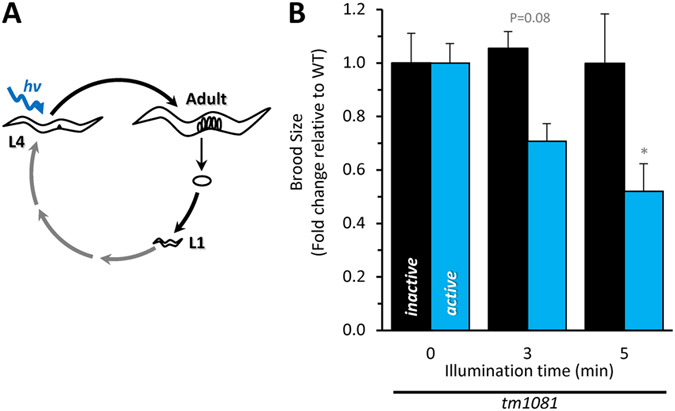
CALI of complex II decreases brood size.(A) Schematic of C. elegans life cycle and light exposure. Staged L4 worms were illuminated (day 0) for the indicated time. (B) Brood size is represented by the total number of viable progeny produced from staged, illuminated L4 larval worms followed over the course of ten days, expressed as a fold change relative to wild-type (“+”) to account for miniSOG-independent effects of blue light and plotted relative to the zero-illumination baseline brood size for each independent strain. Baseline values were 282 ± 11 progeny for “+”, 143 ± 16 progeny for tm1081; inactive and 151 ± 11 progeny for tm1081; active. Daily progeny counts are presented in Figure S8. Data are mean ± SEM. N = 4–6. An “N” is considered an independent trials of 1–5 worms per trial. *Adjusted P < 0.01 vs light-matched inactive counterpart 2-way ANOVA with Sidak multiple comparisons test). Alleles are abbreviated as outlined in Fig. 1.